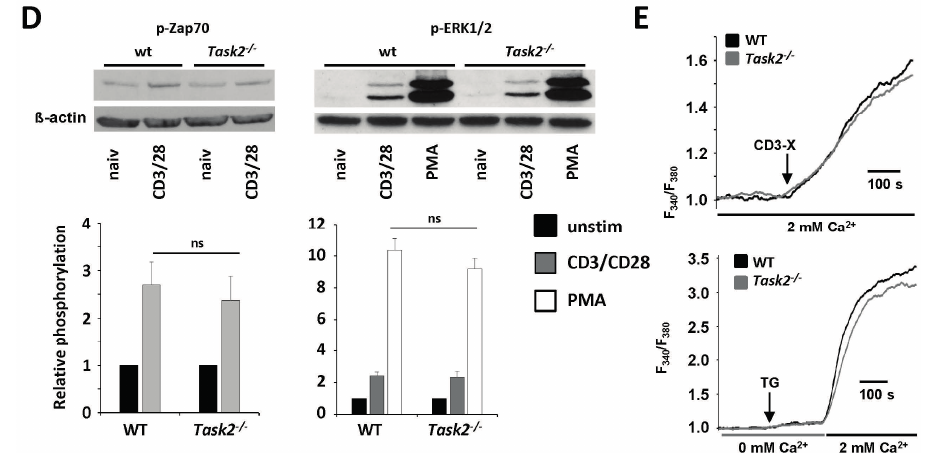
Figure 3. K 2P 5.1 deletion results in a compensatory upregulation of K 2P 3.1 and K V 1.3. ( A ) Relative quantification of unstimulated and stimulated WT and K 2P 5.1 − / − CD4 + and CD8 + T lymphocytes for the expression of K 2P 3.1 , K 2P 9.1 , K V 1.3 and K Ca 3.1 ( n = 5–6); ( B ) Electrophysiological assessment of the resting membrane potential of unstimulated CD4 + T lymphocytes ( n = 10); ( C ) Voltage steps from − 80 to +40 mV for 500 ms were used to record outward currents in stimulated WT and K 2P 5.1 − / − CD4 + T lymphocytes. Current reduction after application of the K 2P 3.1 inhibitor A293 (10 µM) and the K V 1.3 inhibitor Shk (10 nM) ( n = 4) is shown; ( D ) Naive WT and Task2 − / − CD4 + T lymphocytes were stimulated for 10 min either with CD3/CD28 antibodies or PMA followed by cell lysis and Western blot analysis with antibodies against phosphorylated Zap70 (p-Zap70, left panel) and ERK1/2 (right panel). Representative examples (upper panel) and quantitative evaluation (lower panel, n = 4) are shown; ( E ) Calcium imaging experiments using Fura-2 in WT and Task2 − / − CD4 + T lymphocytes were performed under two conditions: T cell-receptor crosslink (CD3-X) in 2 mM Ca 2+ (upper panel) or application of thapsigargin (TG) for intracellular Ca 2+ store depletion in 0 mM Ca 2+ prior to switching to 2 mM Ca 2+ solution (lower panel). One out of five representative measurements are shown. ns = not significant; ** p <